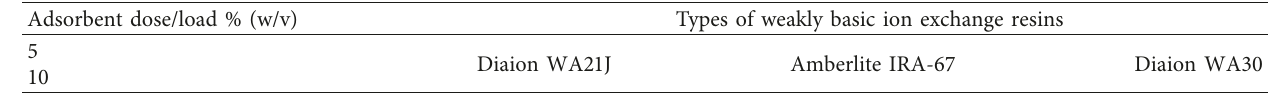
Table 2: Experimental design of saponin adsorption by three different types of ion exchange resins.